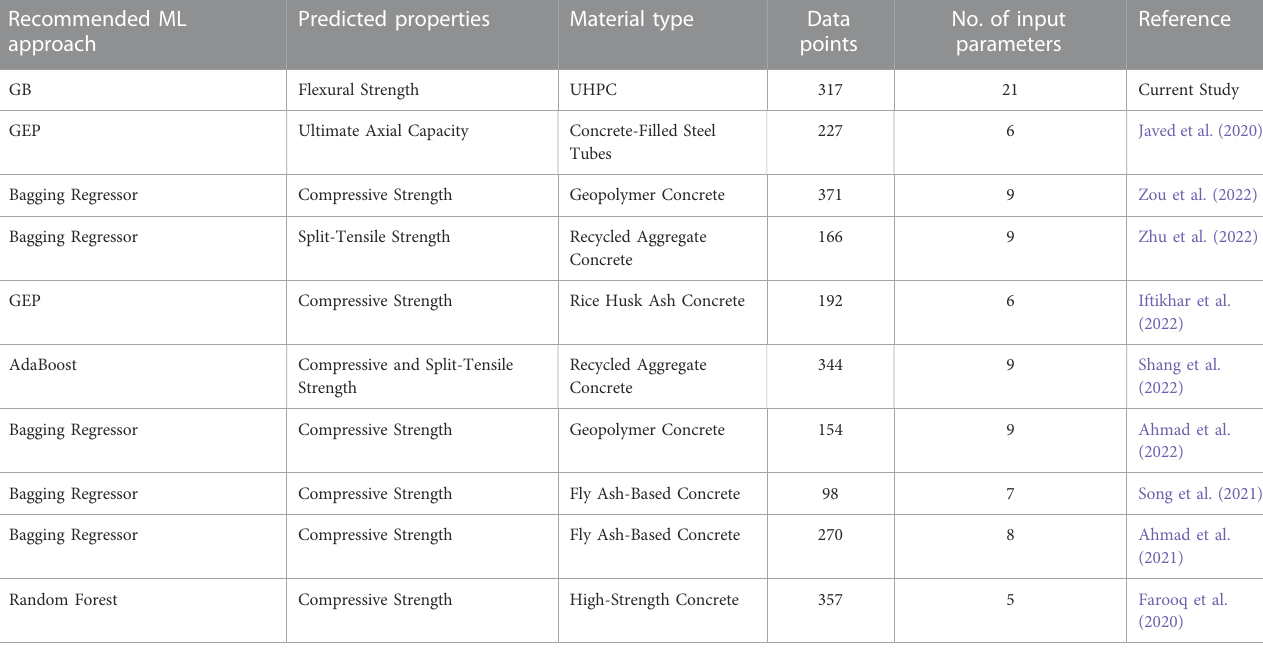
TABLE 2 Literature-based summary of ML models with details of